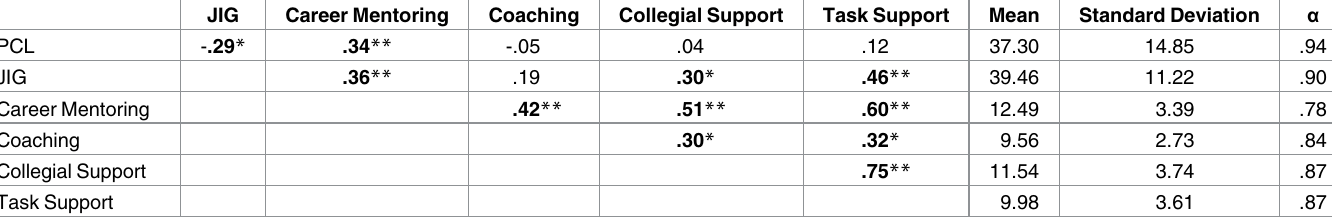
Table 1. Intercorrelations, means, standard deviations and coefficient alphas.